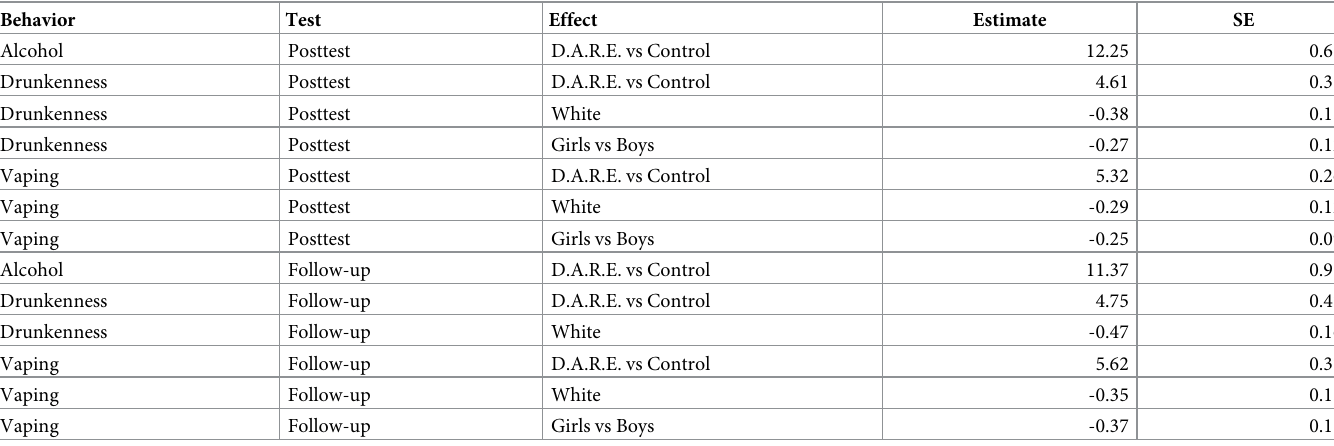
Table 5. Multi-level models: Regression fixed